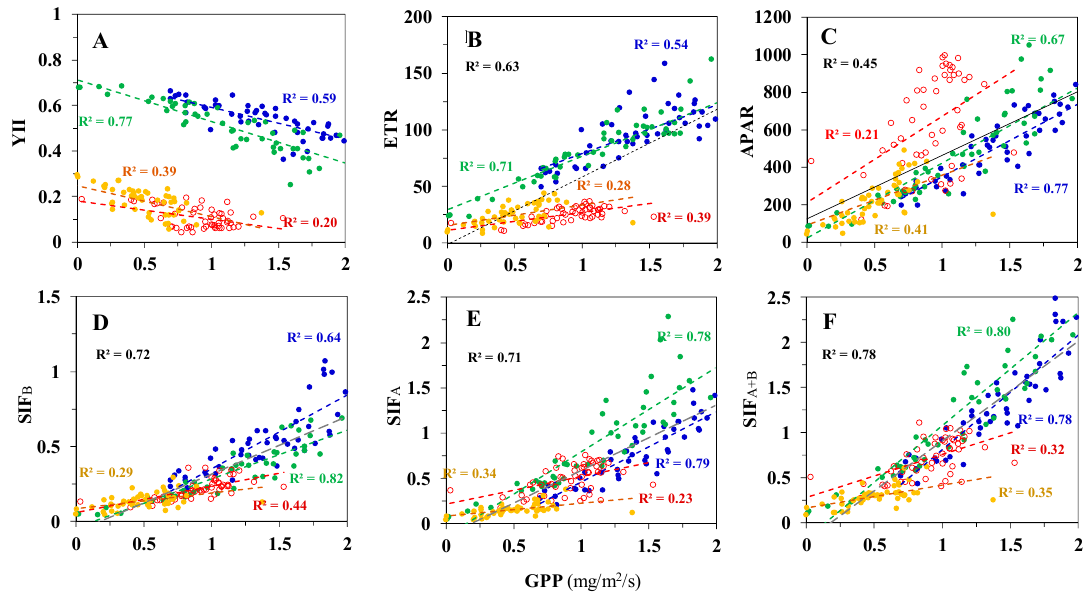
Figure 6. Linear correlation between diurnal observations (8:45–16:45, n = 17/day) of GPP and leaf YII and ETR ( A , B ), absorbed photosynthetically active radiation (APAR, C ), and canopy solar induced fluorescence (SIF, D – F ) metrics. To compare the relationships across growth stages, measurements collected on three consecutive clear days in each growth stage were used (young in blue (n = 51), mature in green (n = 50), senescence in red/initial (n = 51) and yellow/advanced (n = 51)). The linear coefficients of determination (R 2 ) are listed in colors according to growth stage. The overall coefficient of determination for the data from all stages (n = 203) is provided in black when the relationships were statistically significant (p < 0.01). Refer for units to Table 1.